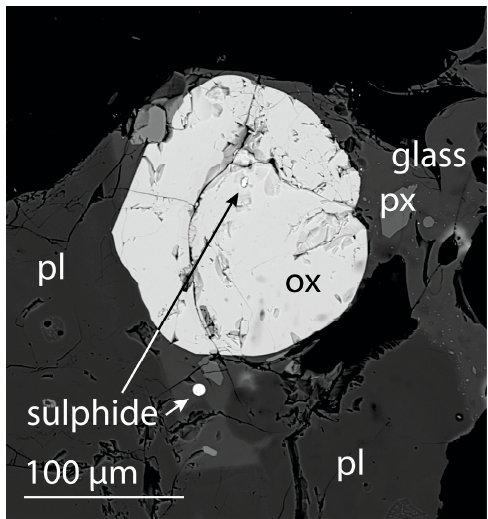
Figure 7. Back-scattered electron image of two spherical Cu–Fe-sulphide grains in the starting andesite, one enclosed in a titano-magnetite phenocryst, the other in matric glass.